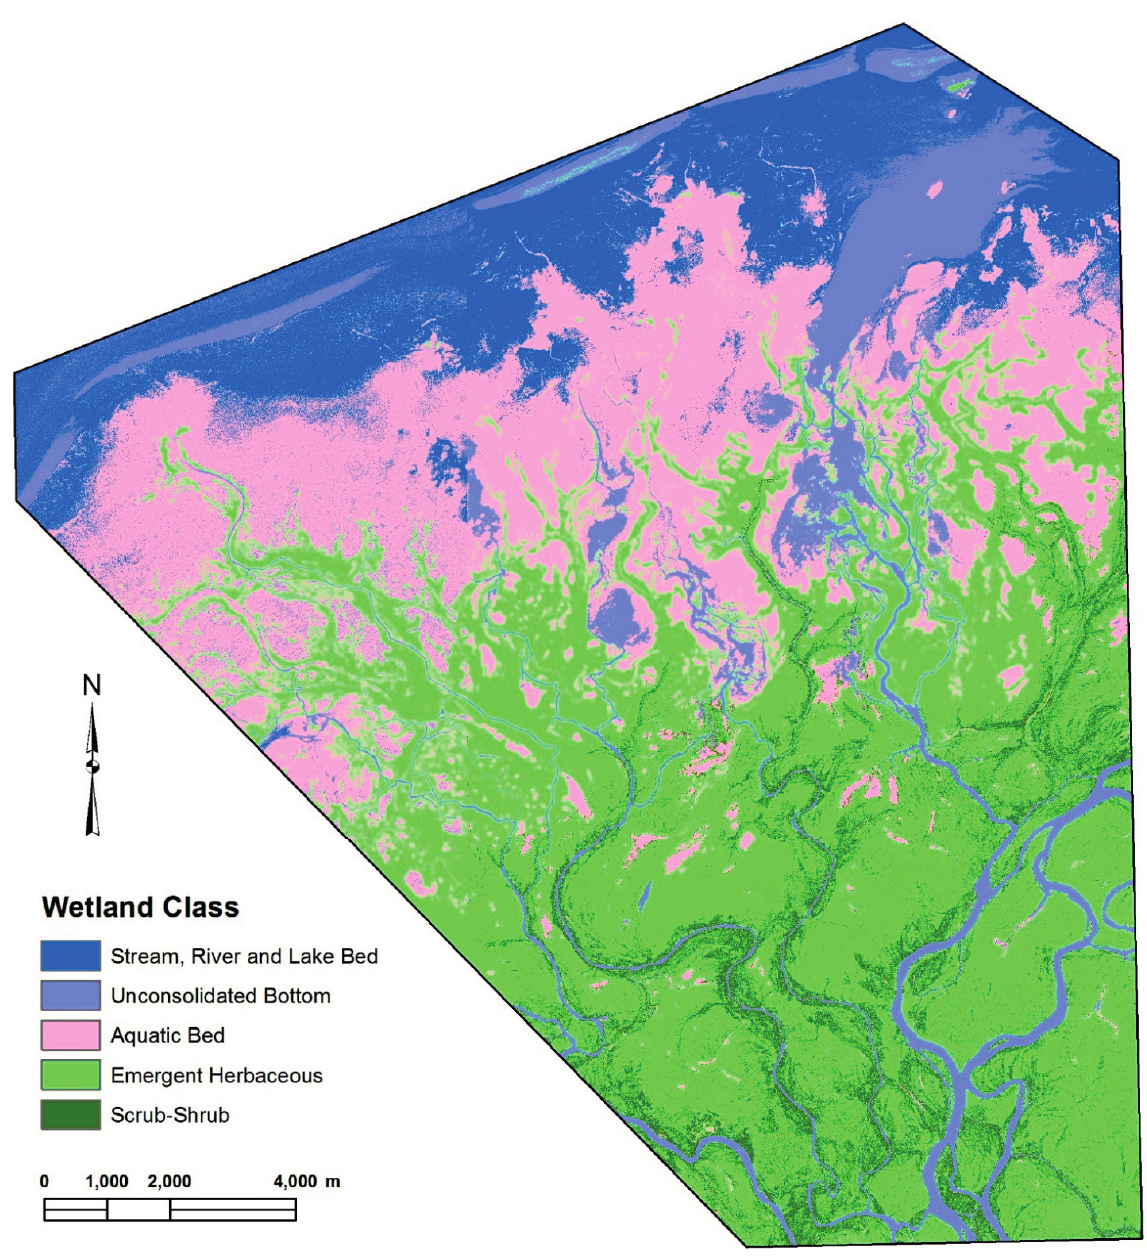
Figure 6. Level 3 classification at the Class level of the Cowardin